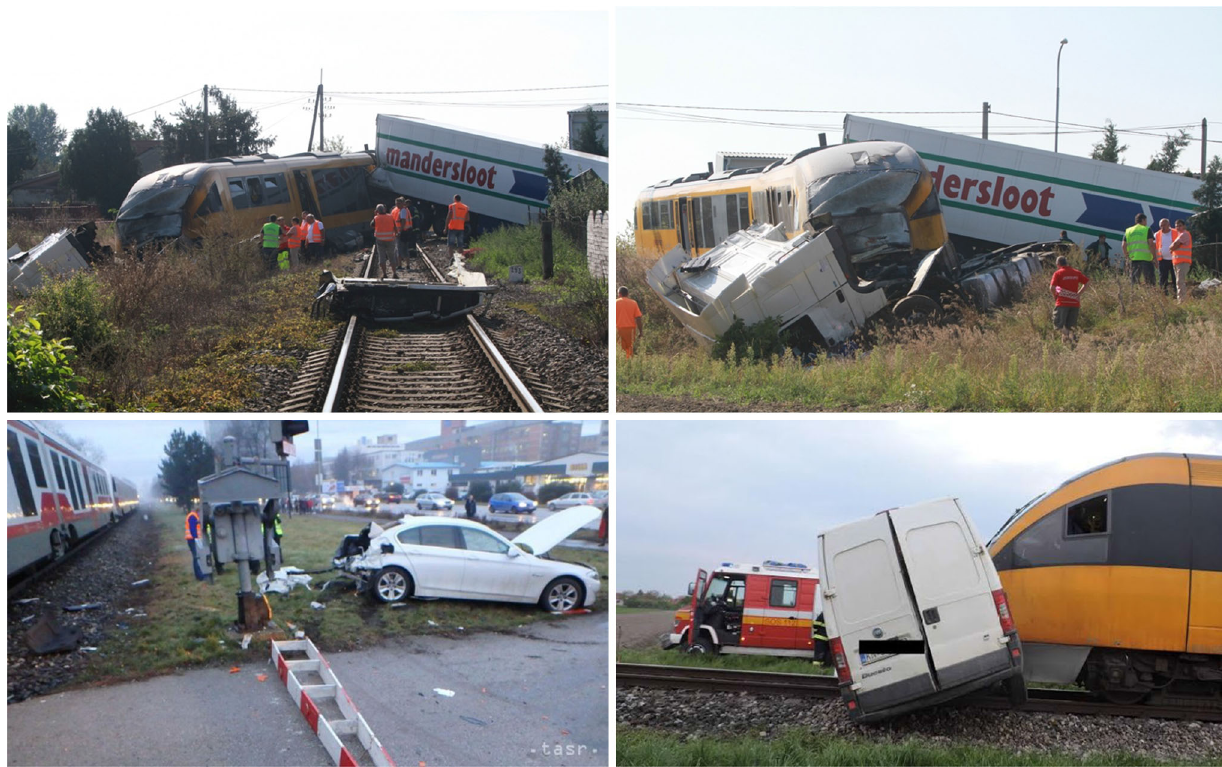
Fig. 1 The illustrative examples of such